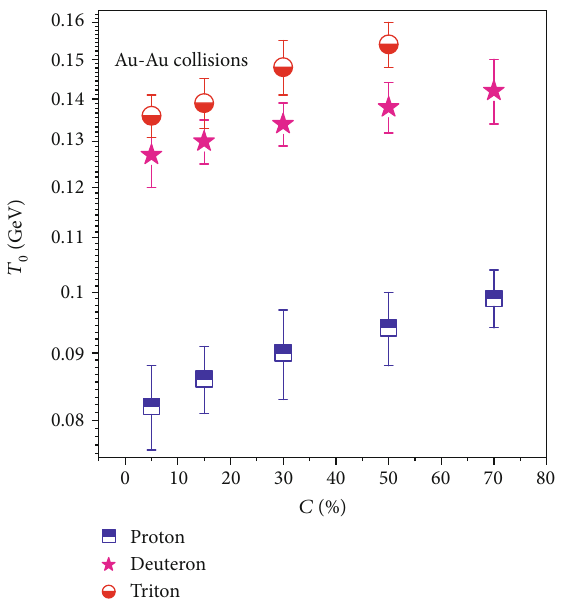
Figure 2: The dependence of T